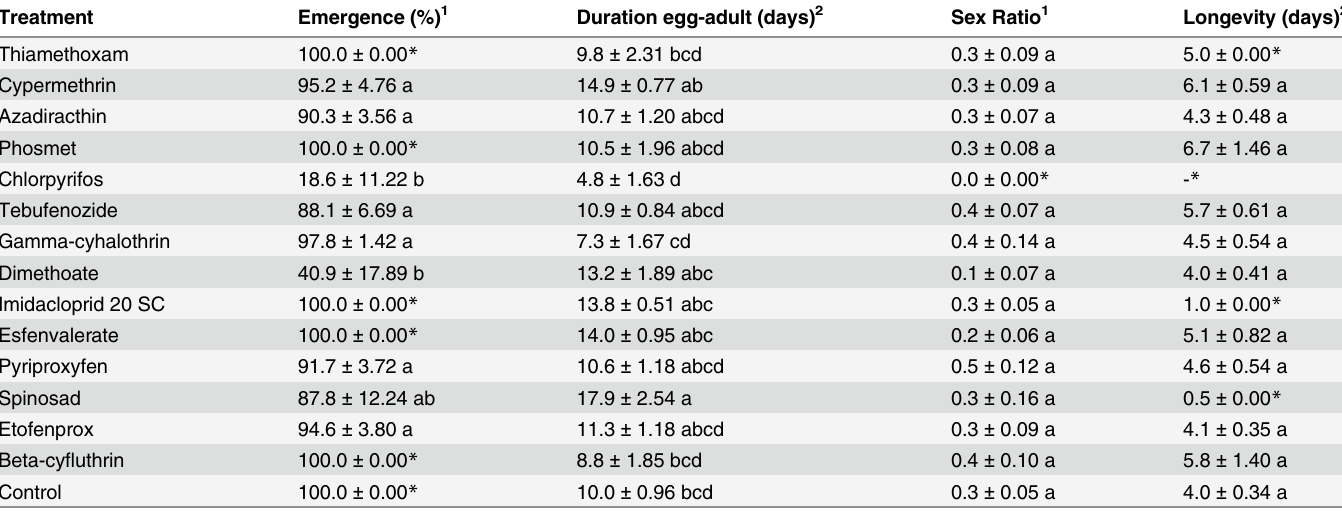
Table 3. Emergence percentage, cycle duration, sex ratio and longevity of the parasitoid Tamarixia radiata sprayed on the 9th day of development (pupal stage), under 25 ± 2°C, 70 ± 10% RH and photoperiod 14 L: 10 D h.